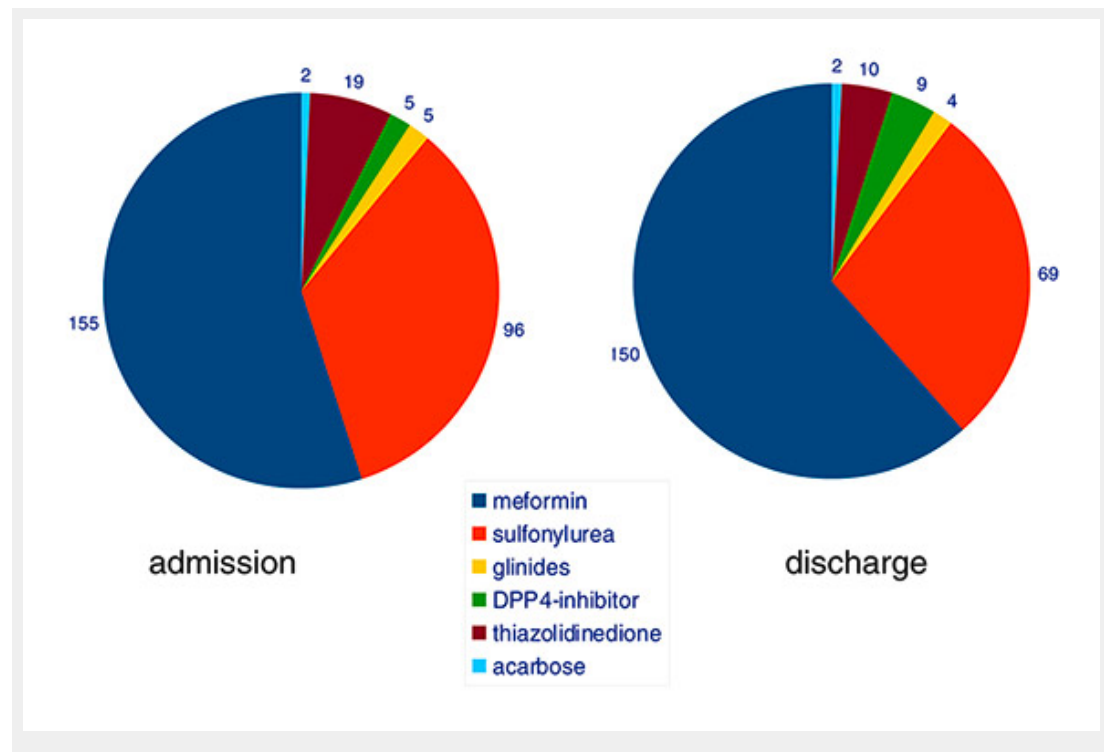
Figure 4 Classes of oral antidiabetic drugs prescribed for patients from group A. Figures indicate absolute numbers of patients treated with each class of drugs. DPP4 = dipeptidyl peptidase